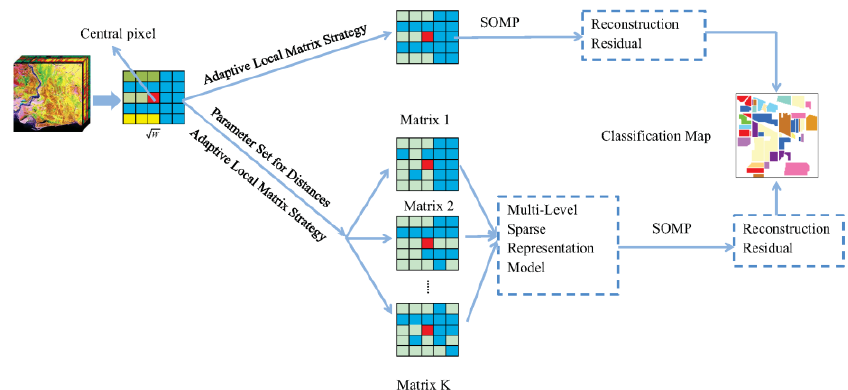
Figure 1. Flowchart of the proposed AJSM and MLSR methods.